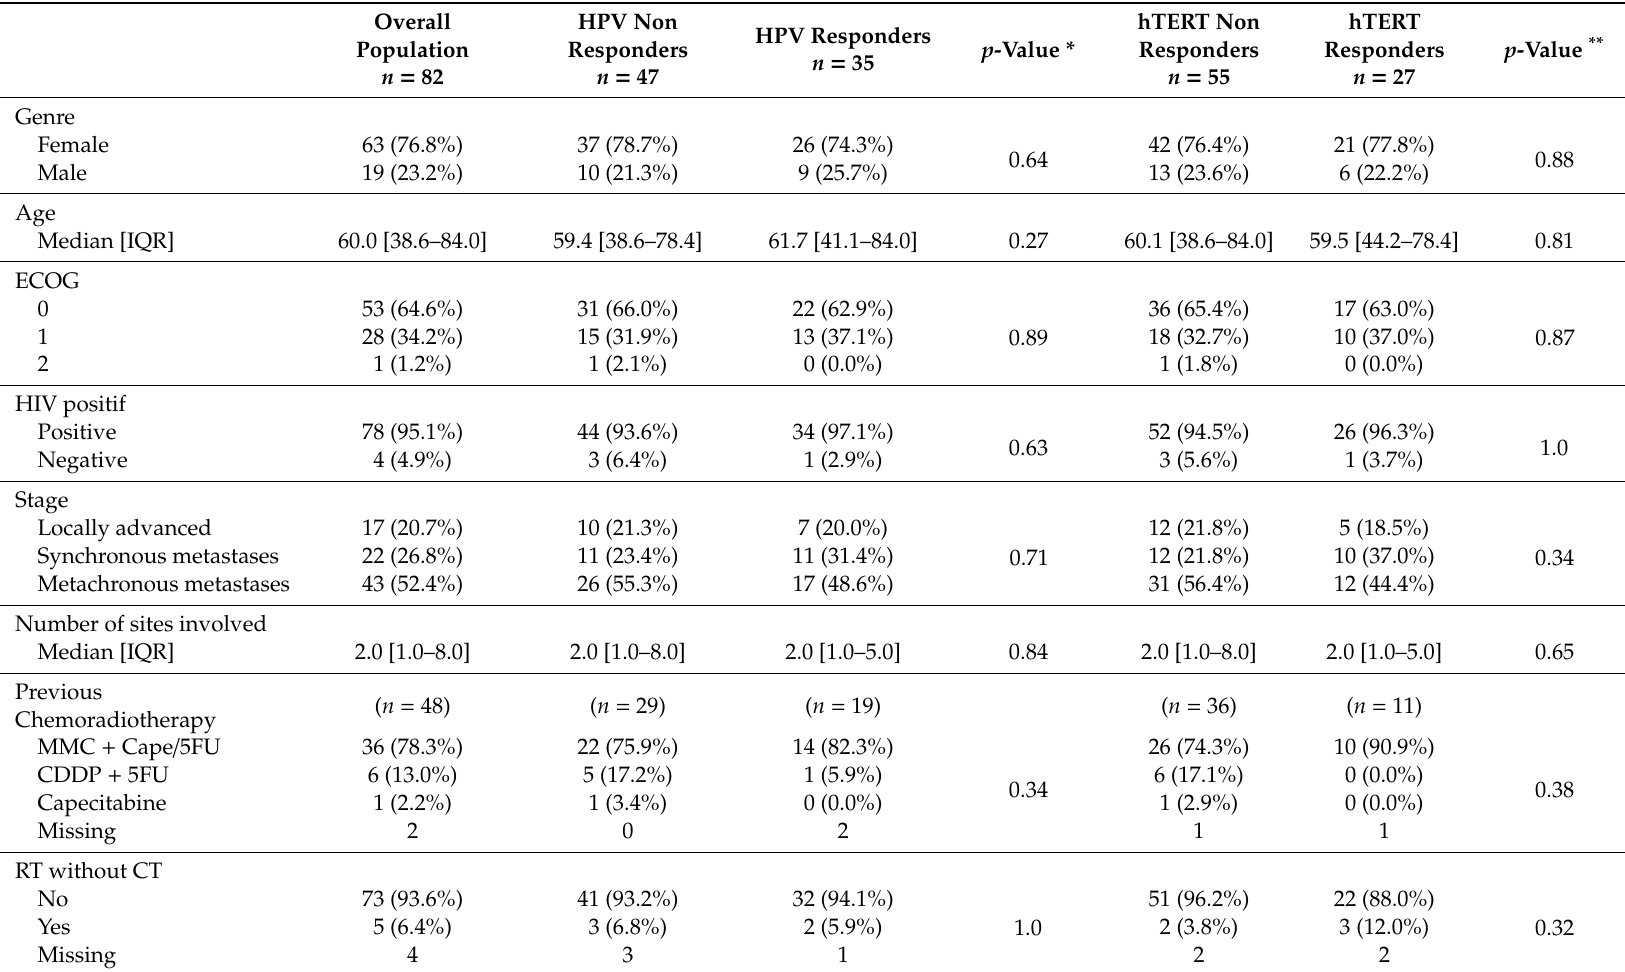
Table 1. Patients’ characteristics in overall population and according to HPV or hTERT immune responses in the peripheral blood at